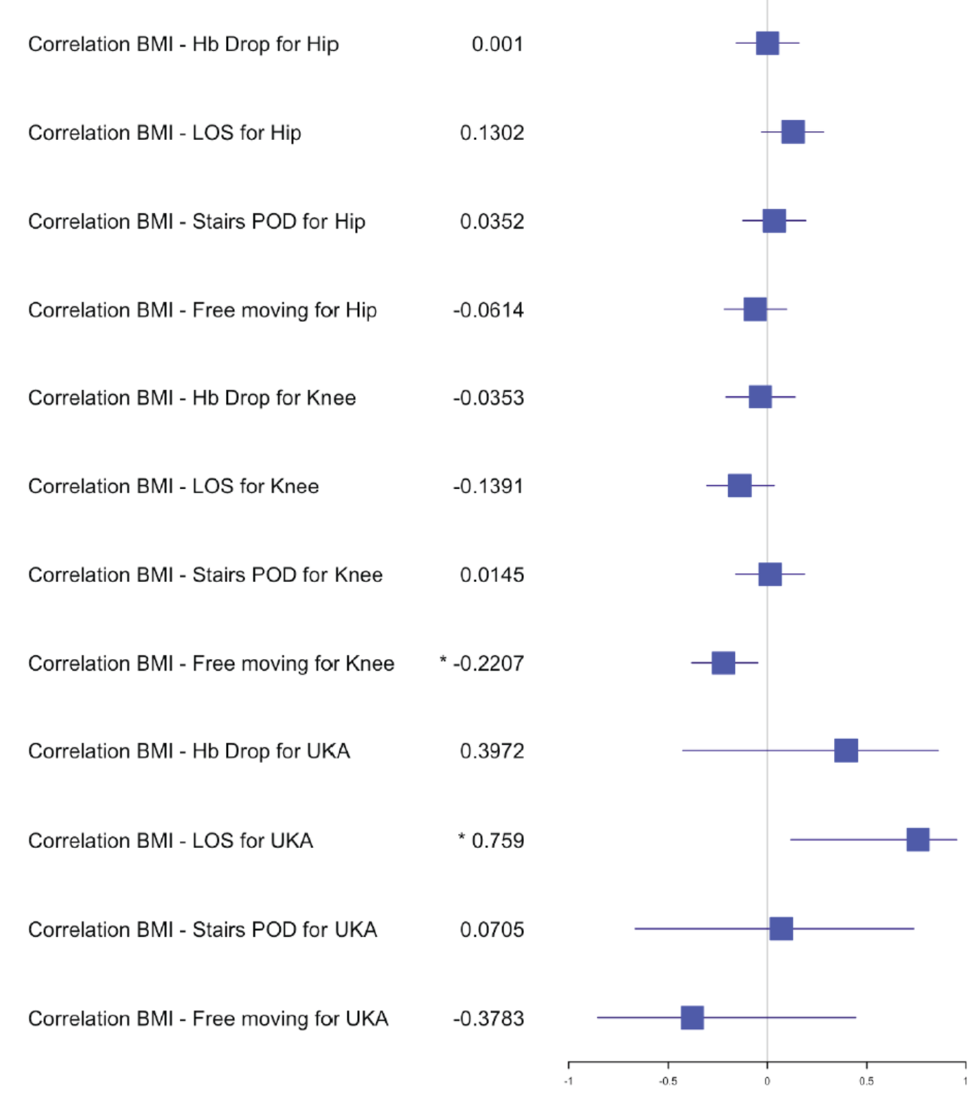
Figure 7. Forest plot for the effects of BMI on Hb drop, LOS and functional outcome for staged arthroplasty. (*) significant results.